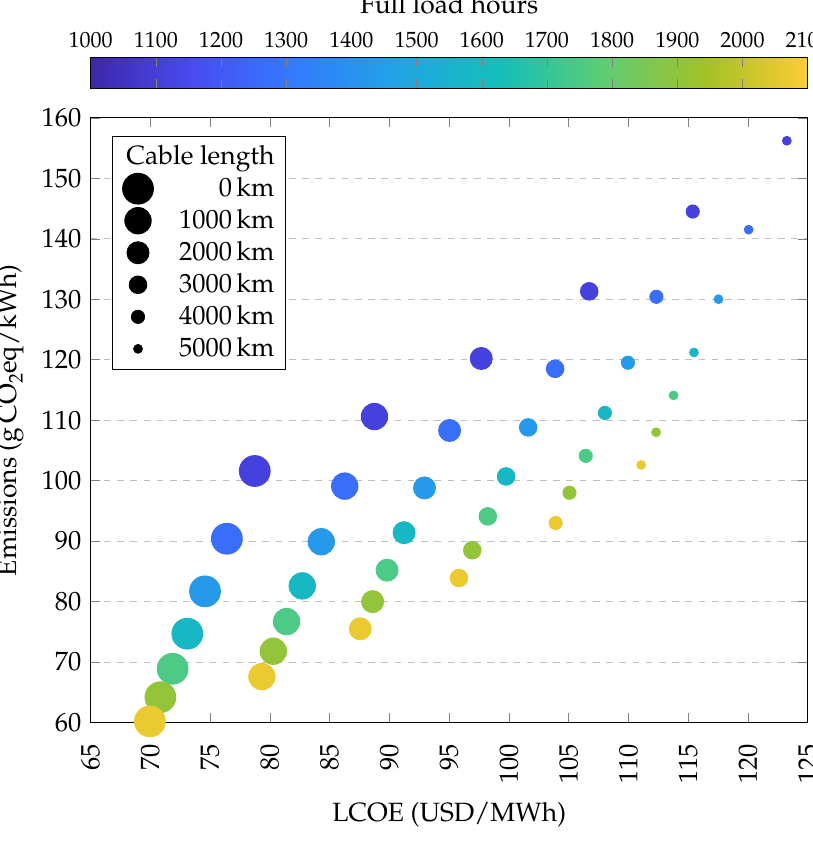
Figure 6. Scatter plot showing specific emissions and LCOE subject to cable length and